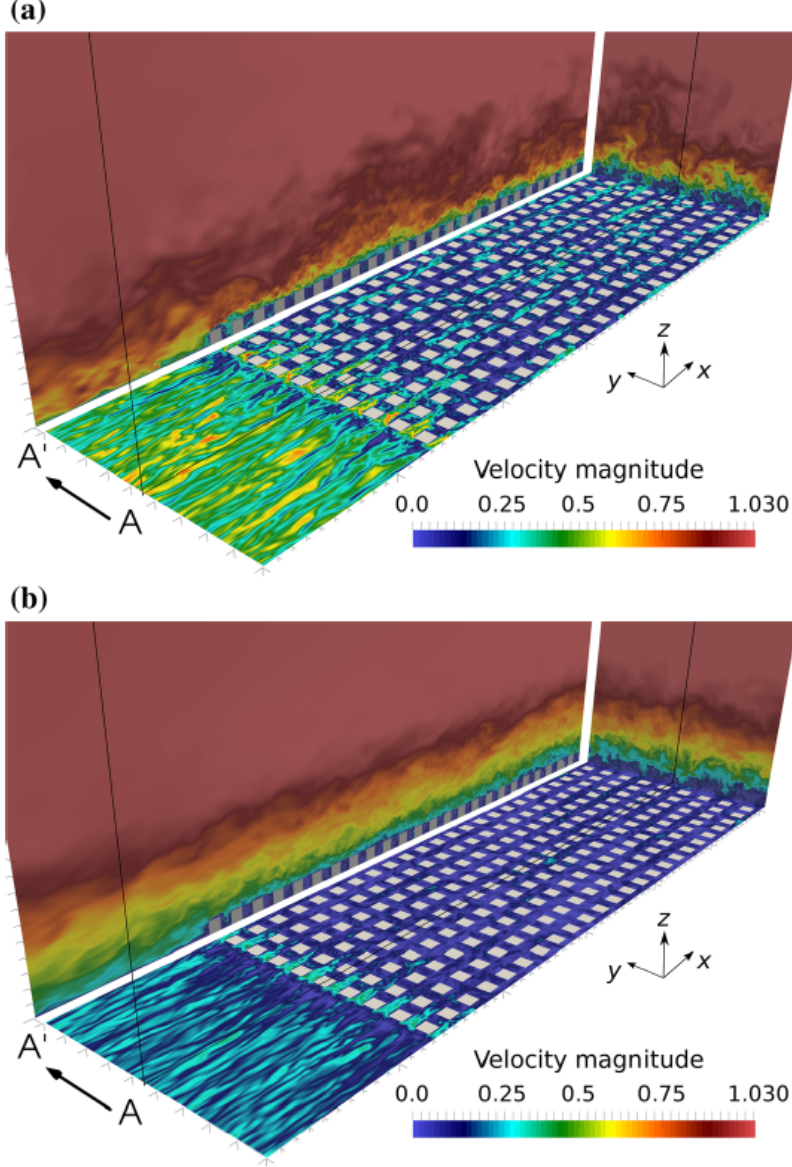
Figure 7. Instantaneous visualization showing the velocity magnitude in a rural-to-urban transition case. ( a ) Neutral- and ( b ) stable-stratification cases are shown, with the velocity magnitude normal- ized by U ∞ . The centerplane is projected on plane A’, and the horizontal plane is located at z / h = 0.1. Reprinted from Ref. [108], with permission of the publisher (Springer